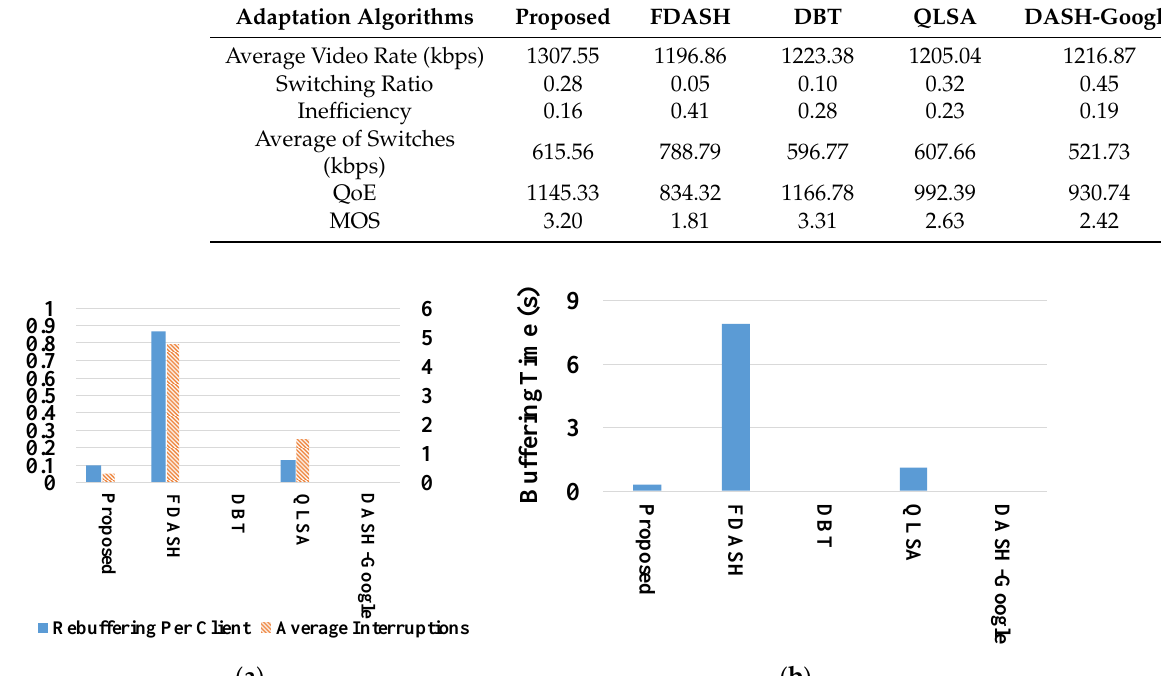
Table 4. Performance of the algorithms with a buffer size of 15 s and segment duration of 2 s.